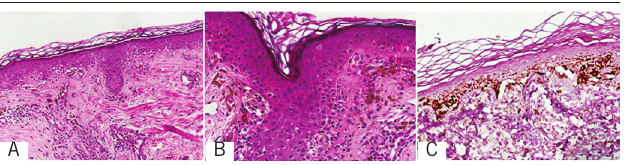
figurE 4 − Case 2: A and B) vacuolated basal keratinocytes, focally forming pseudomelanocytic nests; C) many individual cells and clusters of cells (pseudonests) at the dermo-epidermal junction showed strong positivity for Melan-A, which led to the original erroneous diagnosis of melanoma in situ